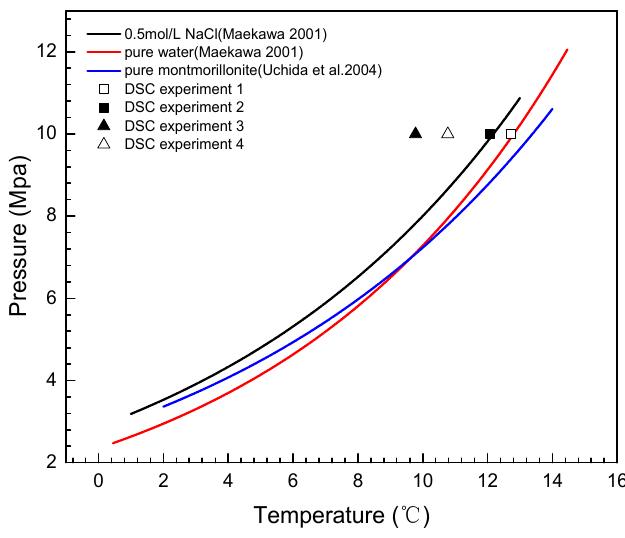
Figure 8. Phase equilibrium curves of methane hydrate in montmorillonite [23,51].